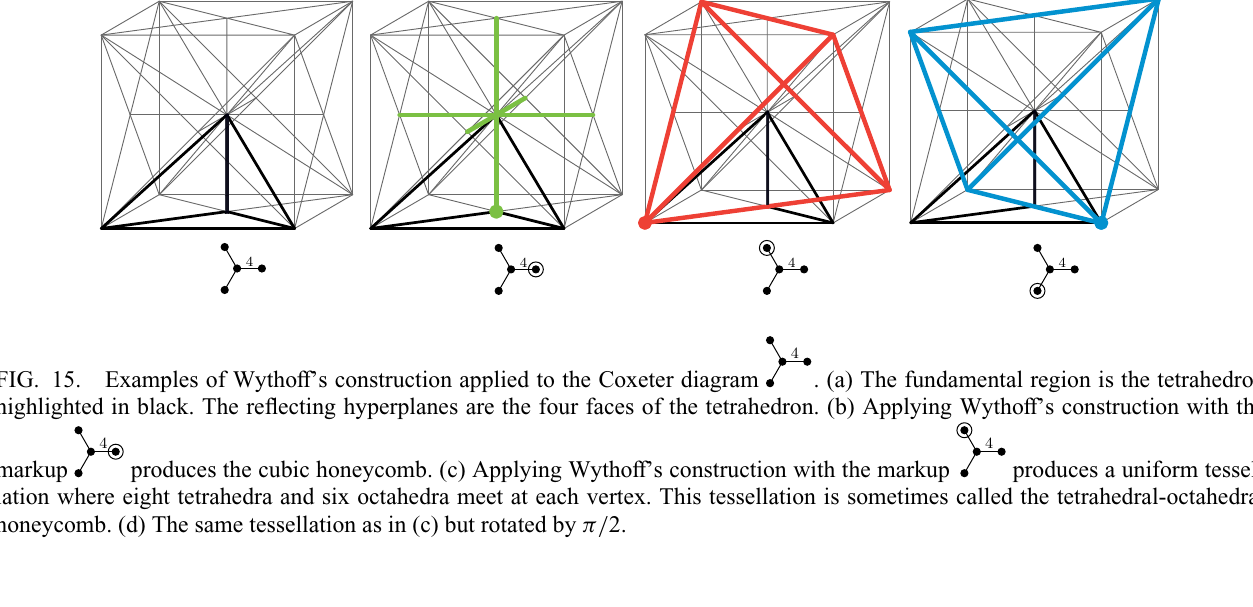
FIG. 15. Examples of Wythoff’s construction applied to the Coxeter diagram highlighted in black. The reflecting hyperplanes are the four faces of the tetrahedron. (b) Applying Wythoff’s construction with the 4 markup produces the cubic honeycomb. (c) Applying Wythoff’s construction with the markup lation where eight tetrahedra and six octahedra meet at each vertex. This tessellation is sometimes called the tetrahedral-octahedral honeycomb. (d) The same tessellation as in (c) but rotated by π/